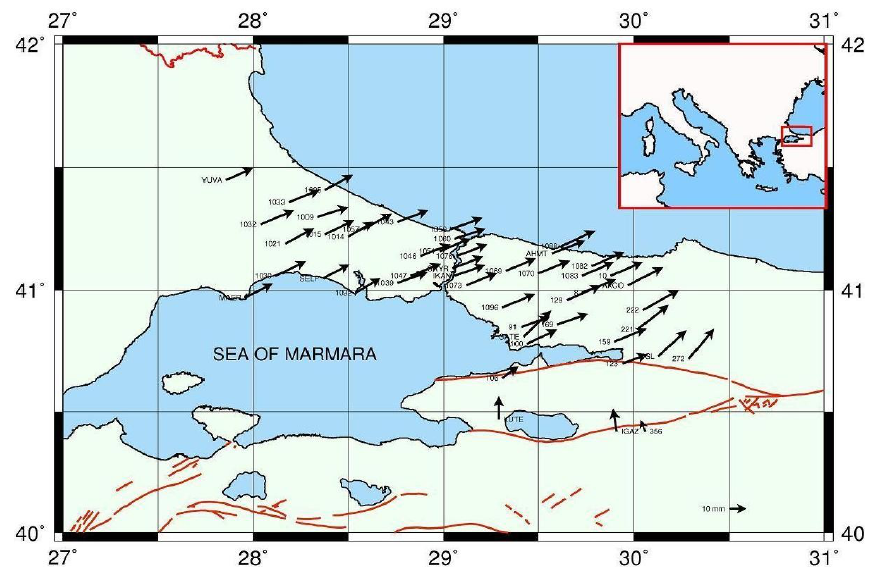
Fig. 1. The study area and the displacement vectors between ITRF96 solution at epoch 2000.45 and ITRF2000 solution at epoch 2006.60 on the test network of